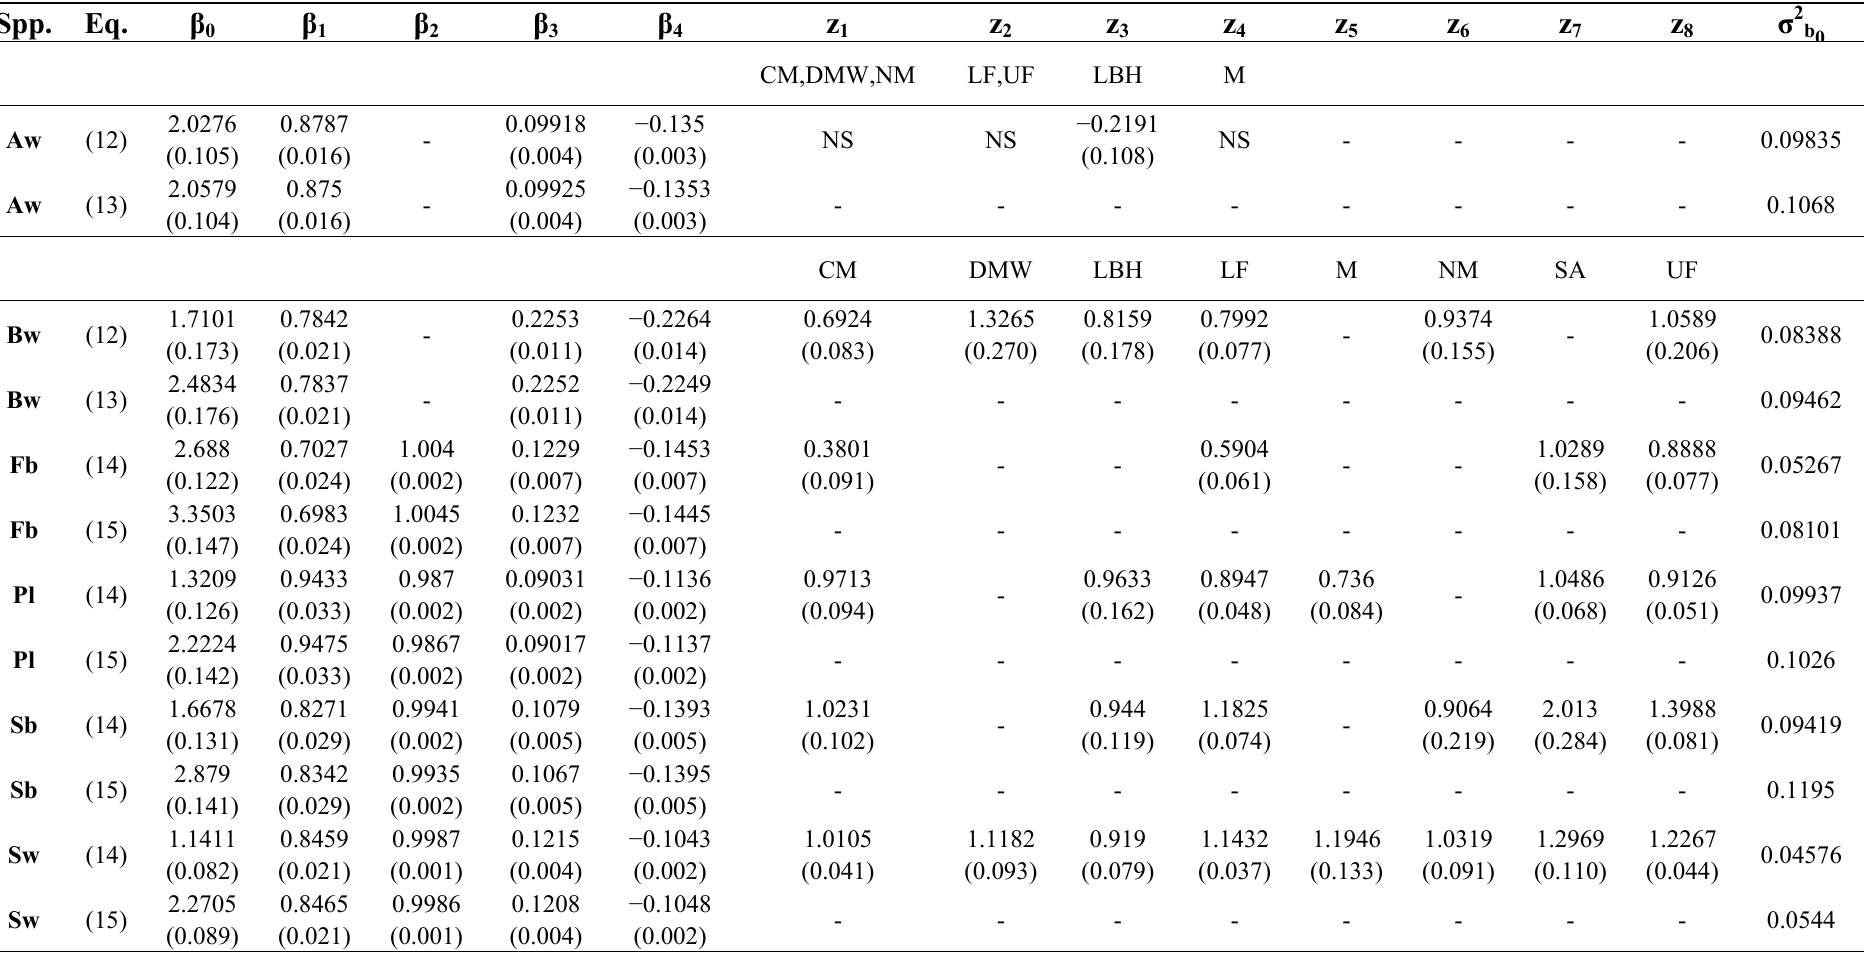
Table 7. Mixed model analysis (plot as the random subject): parameters estimates (reported with standard errors) of models with tree diameter modeled as a function of height, crown area, basal area of the larger trees and natural sub-regions ( i.e. , Equations (12) and (14)), or without natural sub-regions ( i.e. , Equations (13) and (15)), for trembling aspen and white birch, Equations (12) and (13); and for balsam fir, lodgepole pine, black spruce and white spruce, Equations (14) and (15), as described in Section 2.4.